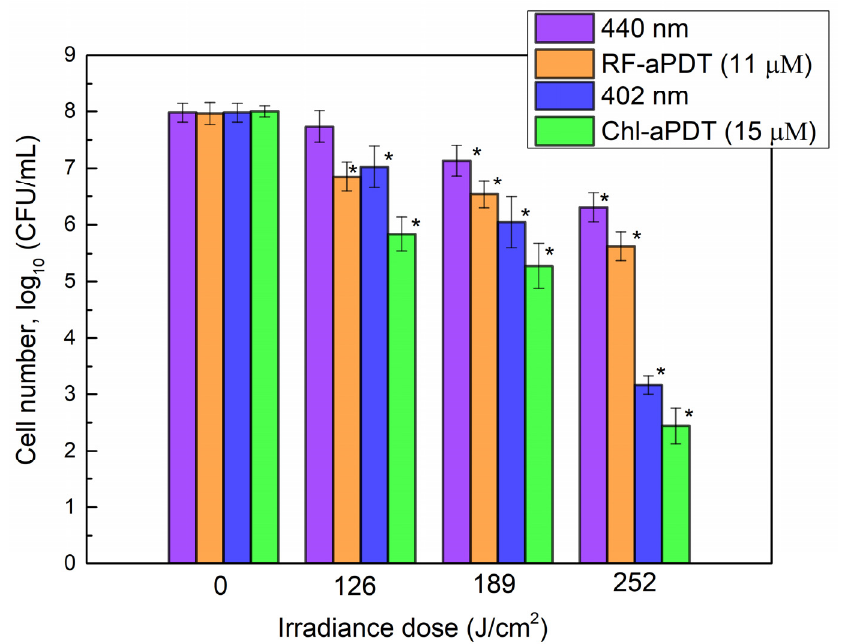
Figure 4. Photodynamic inactivation of A. baumannii biofilms by RF-aPDT and Chl-aPDT with 11 µM RF and 15 µM Chl, presented in numbers of the surviving cells as a function of irradiance doses. CFU values present the average of three independent experiments, error bars indicate standard deviation. * Shows statistical significance compared to the control culture, p < 0.05.